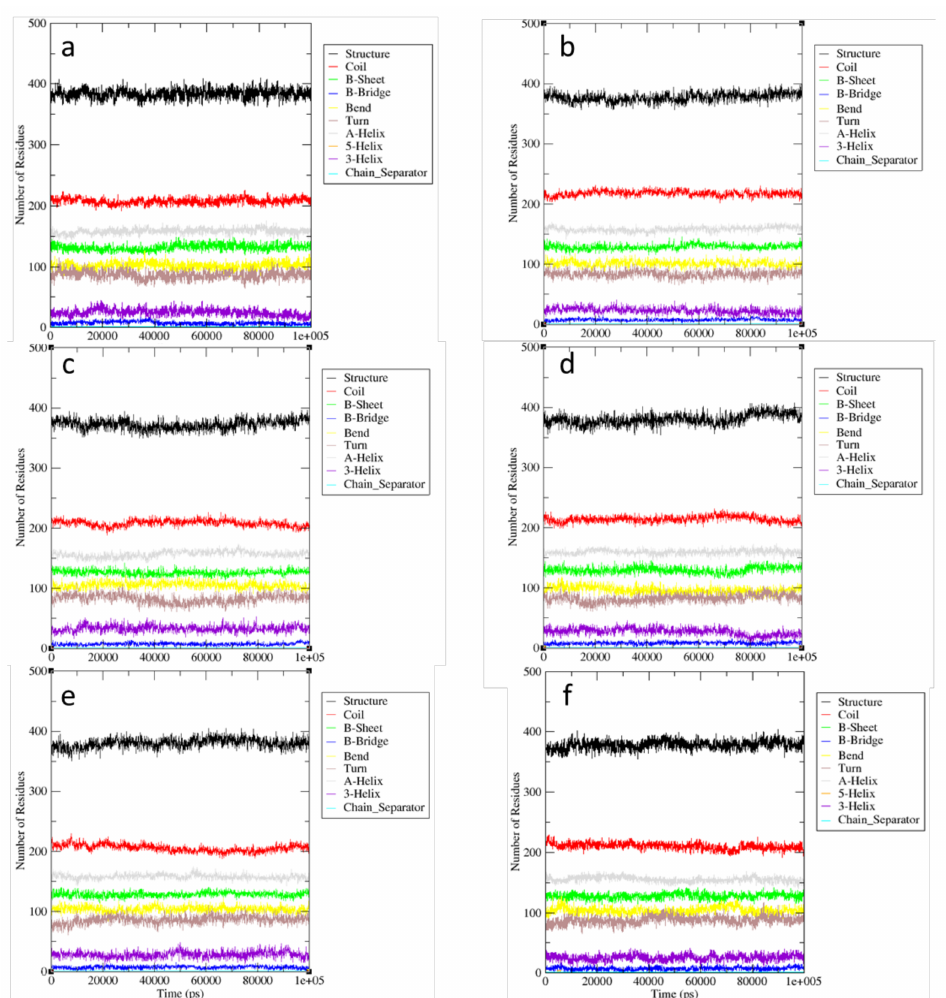
Figure 3. Representative results of DSSP analysis for simulations with arginine in the active site. ( a ) wtGALT + arginine; ( b ) p.Gln188Arg + arginine; ( c ) wtGALT + G1P + arginine; ( d ) p.Gln188Arg + G1P + arginine; ( e ) wtGALT + H2U + arginine; ( f ) p.Gln188Arg + H2U +